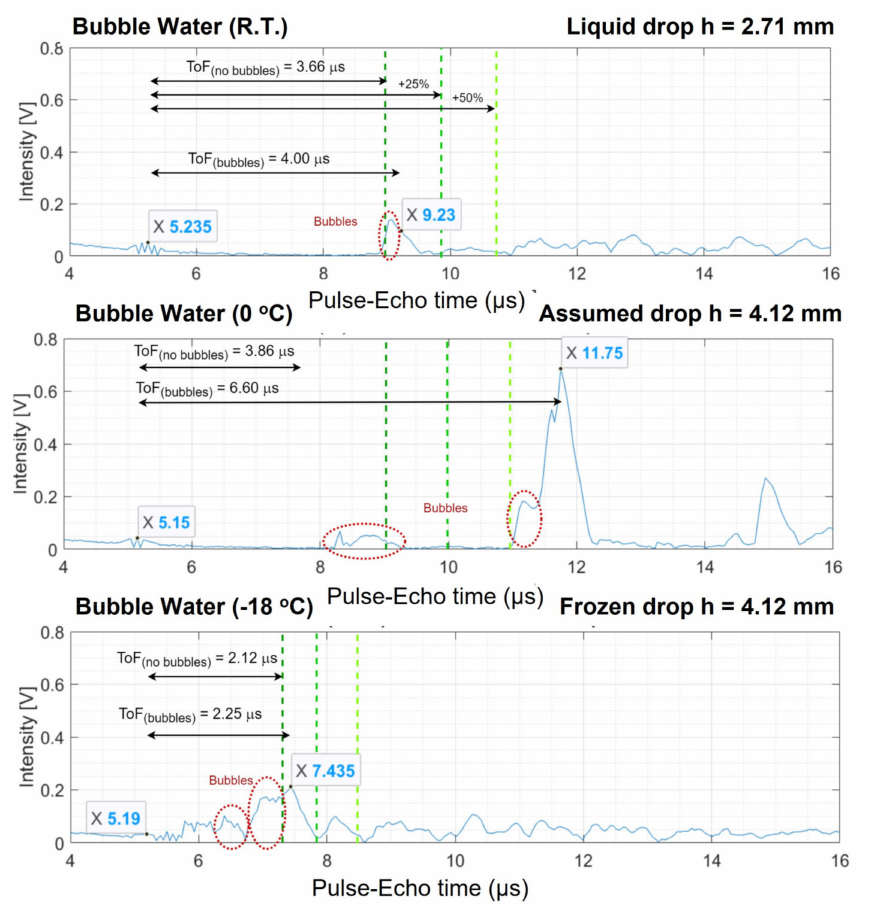
Figure 9. Typical set of A-scans for Drop Experiment 2 for three different temperature values, the ToF of the hypothetical compact ice (without bubbles) is drawn as the dark green dotted line. The other green dotted lines indicate lines of 25% and 50% beyond this ToF. The ToF of the top of the porous drop surface is labelled as ToF (bubbles) . The peaks that likely indicate bubbles are shown in the red dotted circles.